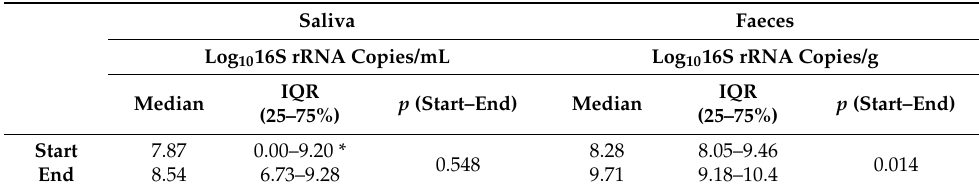
Table 7. Quantification of lactobacilli in in vivo